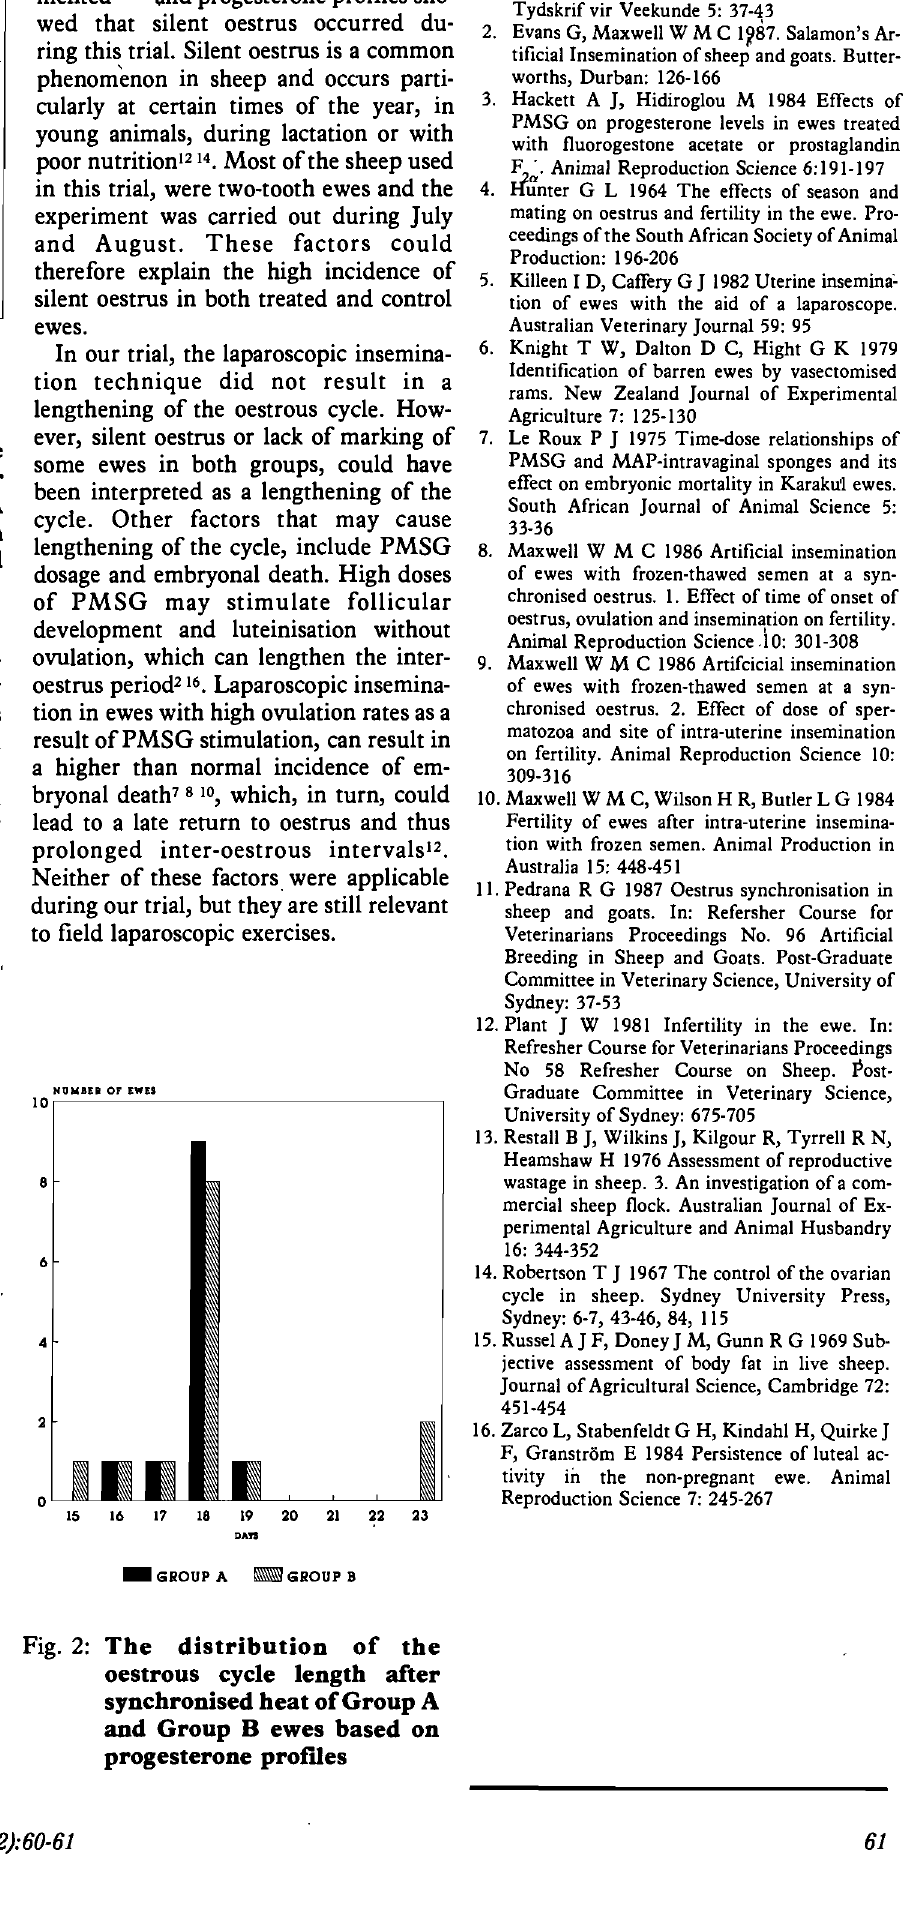
Fig. 2: The distribution of the oestrous cycle length after synchronised heat of Group A and Group B ewes based on progesterone